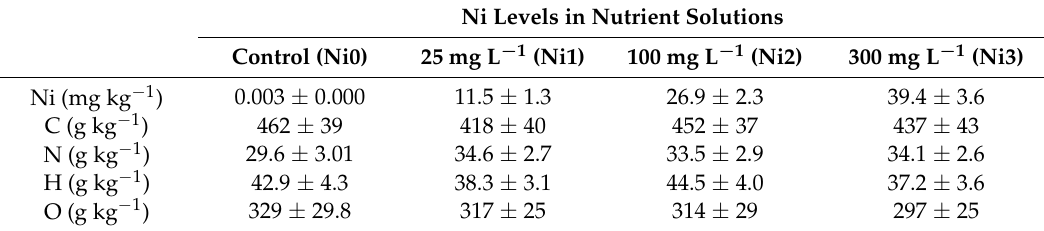
Table 2. Element contents of the iris roots obtained from plots with different Ni levels added. Mean ( ± SE, n =